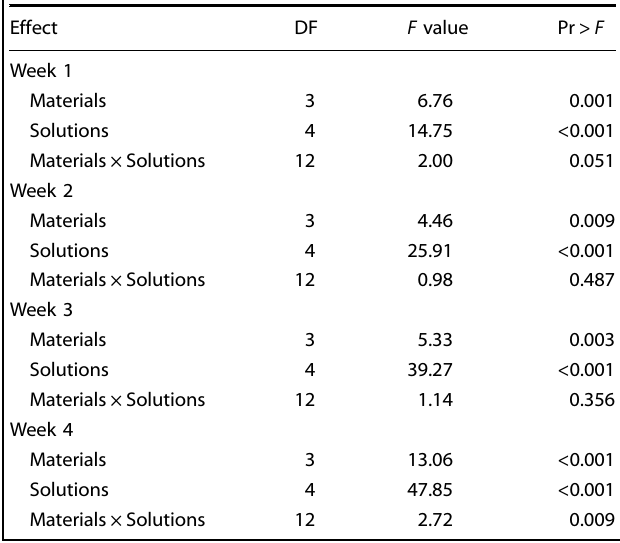
Table 3. Two-way analysis of variance.